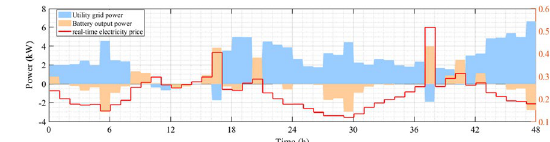
Fig. 4 First-stage economic dispatch without considering the uncertainty